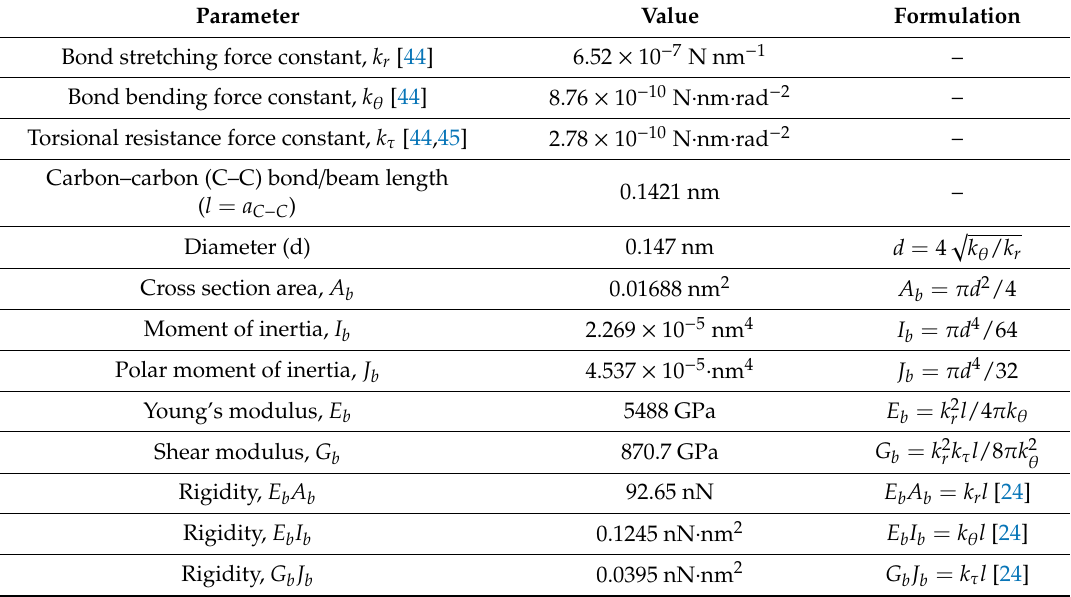
Table 1. Input parameters for finite element (FE) simulations of the layers (single-walled carbon nanotubes, SWCNTs) of multiwalled carbon nanotubes: material and geometric properties of beam